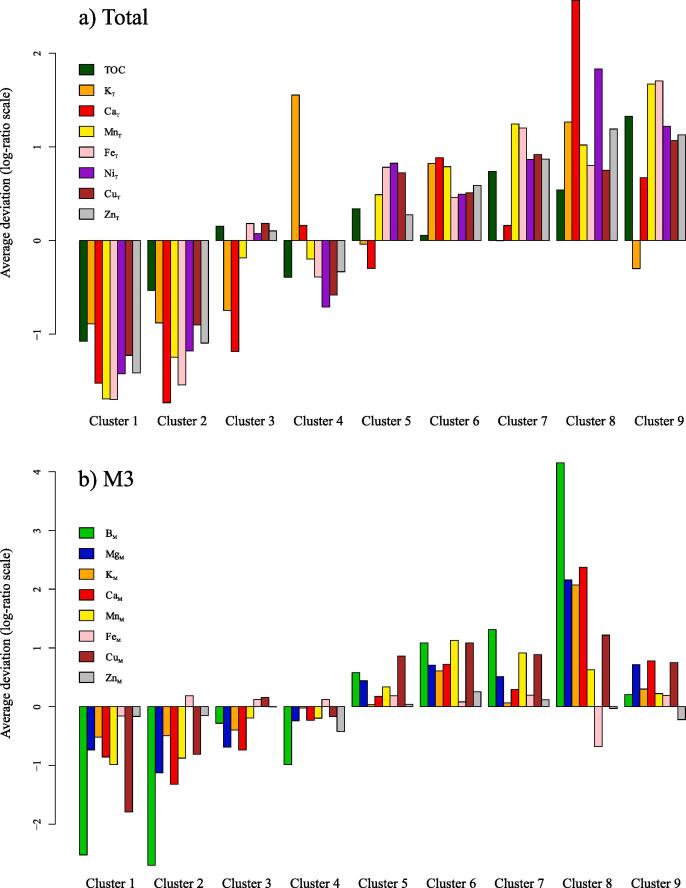
Total (a) and M3 (b) average nutrient concentrations of each cluster expressed as deviation in log-ratio scale from the overall geometric mean of the dataset (i.e. all 935 subsoils; at zero reference line). Values below zero represent average concentrations lower than that for the entire dataset, whilst values above zero represent the opposite.